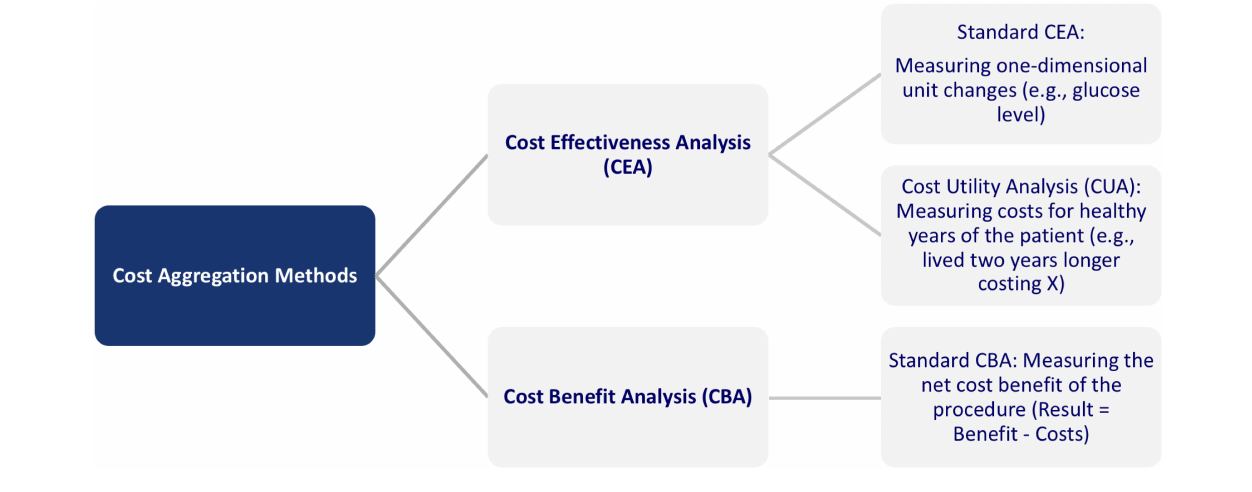
FIGURE 6 | Overview of cost aggregation methods in healthcare